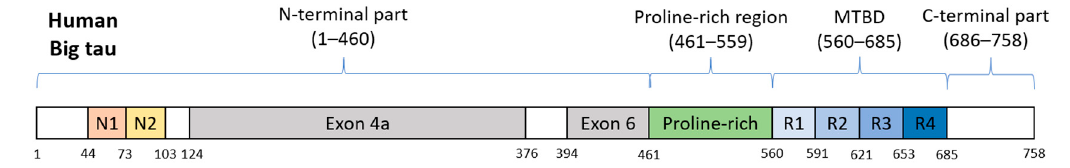
Figure 3. Schematic representation of human Big tau. Its counterparts in rat and mouse possess 752 or 733 aa and share 74.9% or 74.2% identity, respectively. Exons 4a and 6 are responsible for differentiation from the brain tau protein.